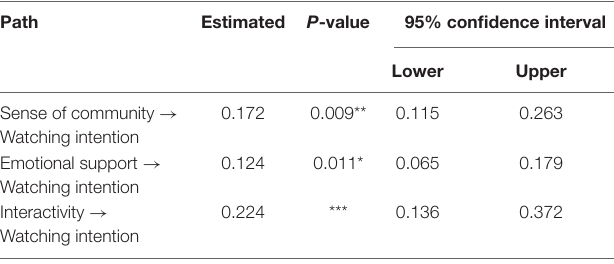
TABLE 6 | Standardized indirect effects and 95% confidence